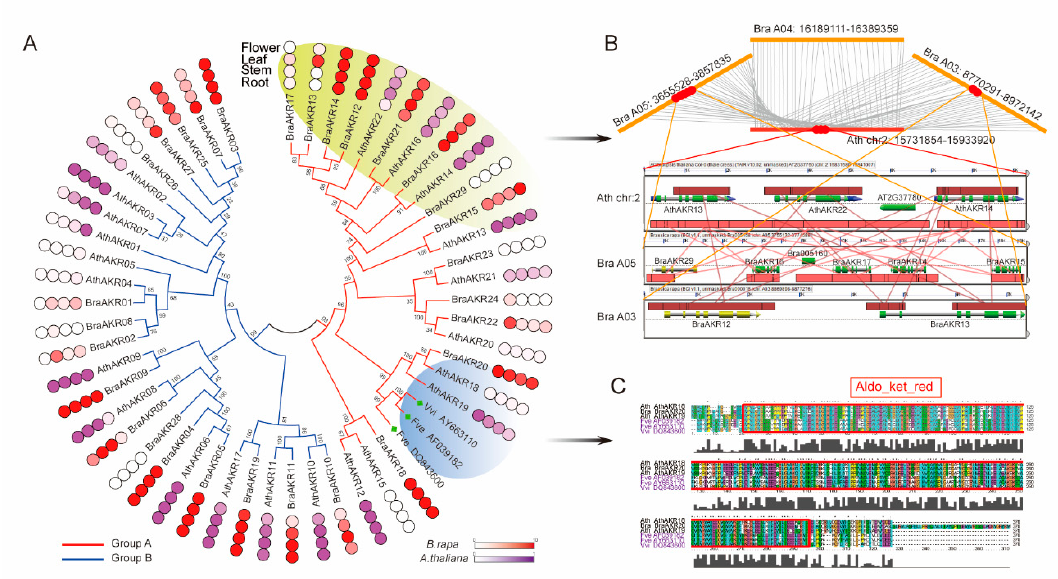
Figure 4. Expression patterns and evolutionary characteristics of aldo-keto reductases ( AKR ) genes in A. thaliana and B. rapa . ( A ) Phylogenetic relationship and expression pattern of AKRs in A. thaliana and B. rapa . The tissue expression analysis included root, stem, leaf, and flower. (B ) Micro-syntenic analysis of part of the AKR genes in A. thaliana and B. rapa genome. ( C ) Multiple sequence alignments of GalUR orthologs.